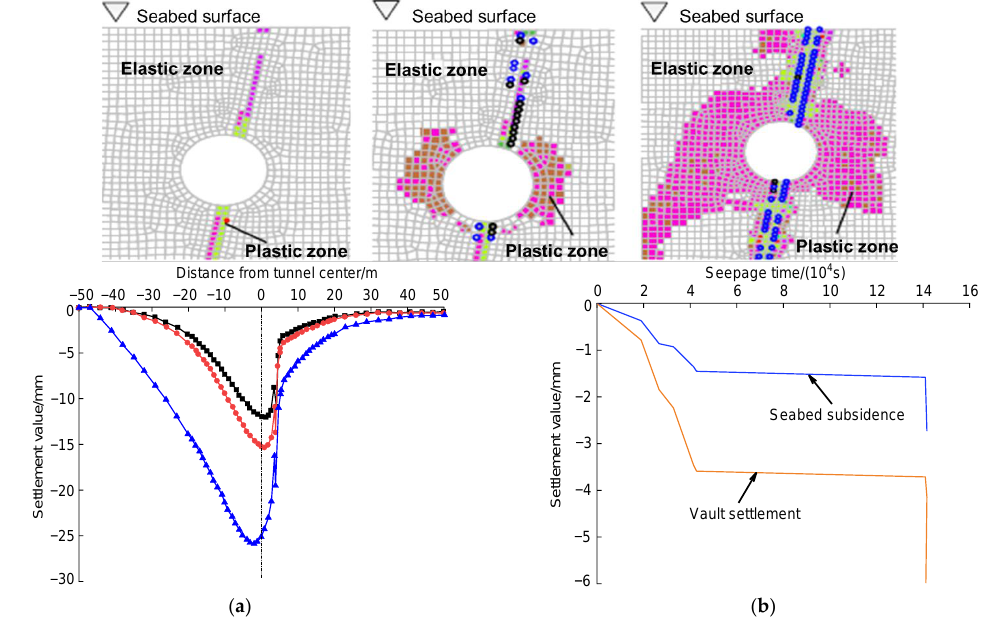
Figure 16. Evolution process and characteristics of interface slip formation [67]. ( a ) Changes in sea- bed settlement; ( b ) corresponding relationship between seabed and dome settlement.